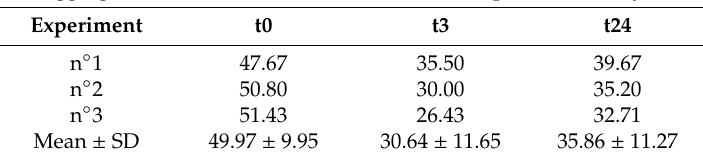
Table 6. Aggregate count number details in shocked mutant p.R239C embryos, with the mean and the respective SD reported at t0, t3, and t24.